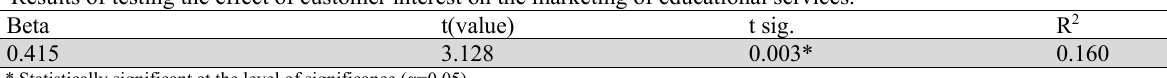
Results of testing the effect of customer interest on the marketing of educational services.